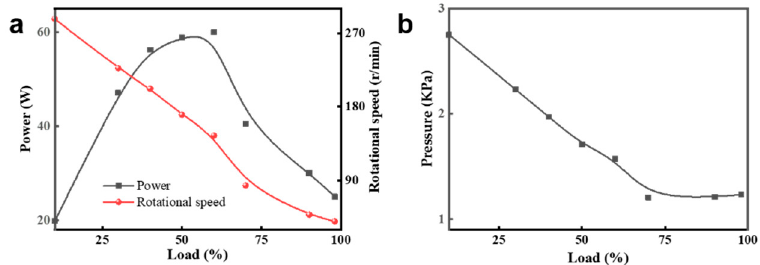
Figure 10. Effect of blade load on PTO under different load conditions: ( a ) rotational speed and power; ( b ) dynamic pressure.